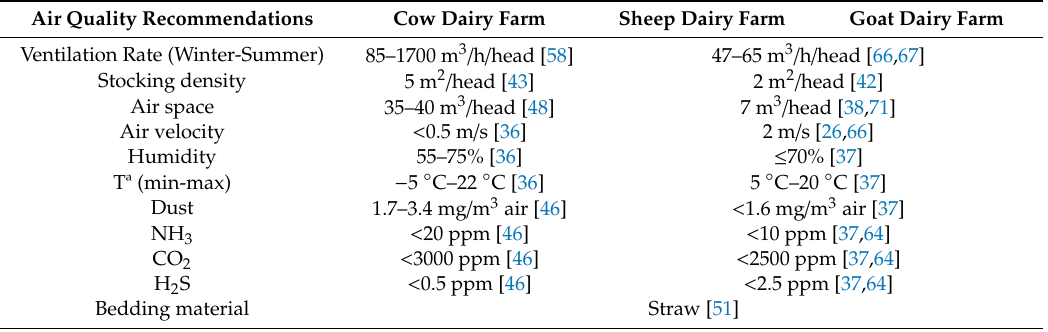
Table 1. Recommendations in some parameters of the dairy farm environment to proper sanitary environmental conditions and, consequently, improve the quality of the final